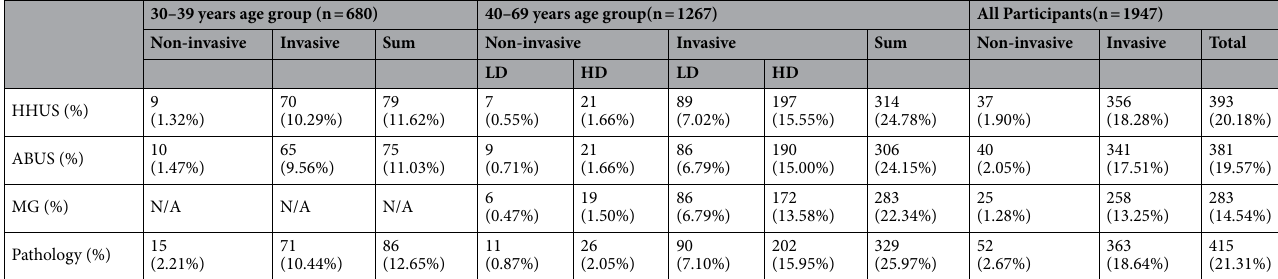
Table 2. Cancer Detection of HHUS, ABUS and MG. LD: lower-Low-density breast subgroup; HD: High- density breast subgroup; SUM: summation.